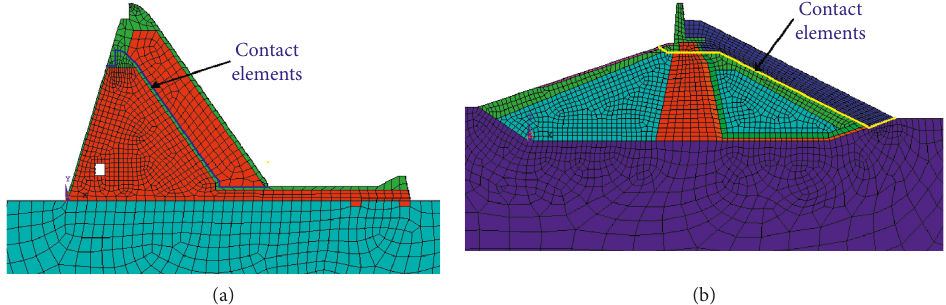
Figure 17: Critical sections analyzed: (a) concrete critical section and (b) soil critical section.